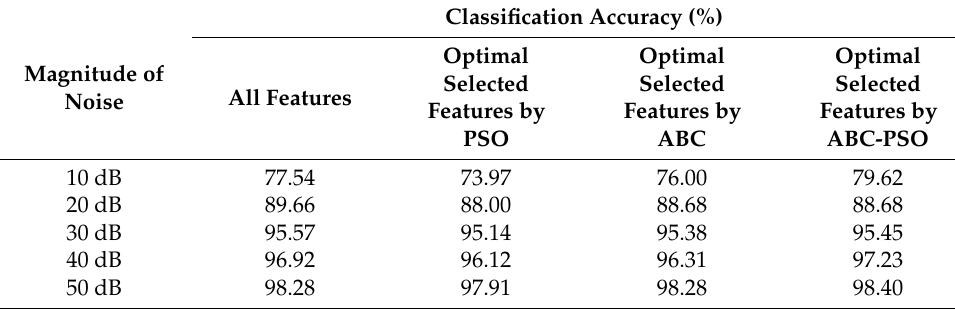
Table 7. Classification accuracy under a noisy